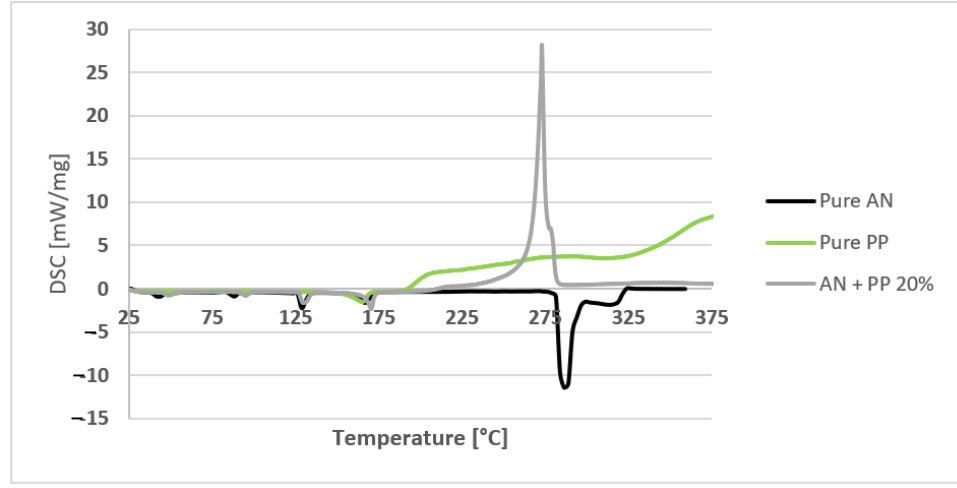
Figure 2. DSC analysis showing the course of reaction of pure AN, pure polypropylene (PP) and their mixture (containing 20% of the polymer), heat rate 10 °C/min.